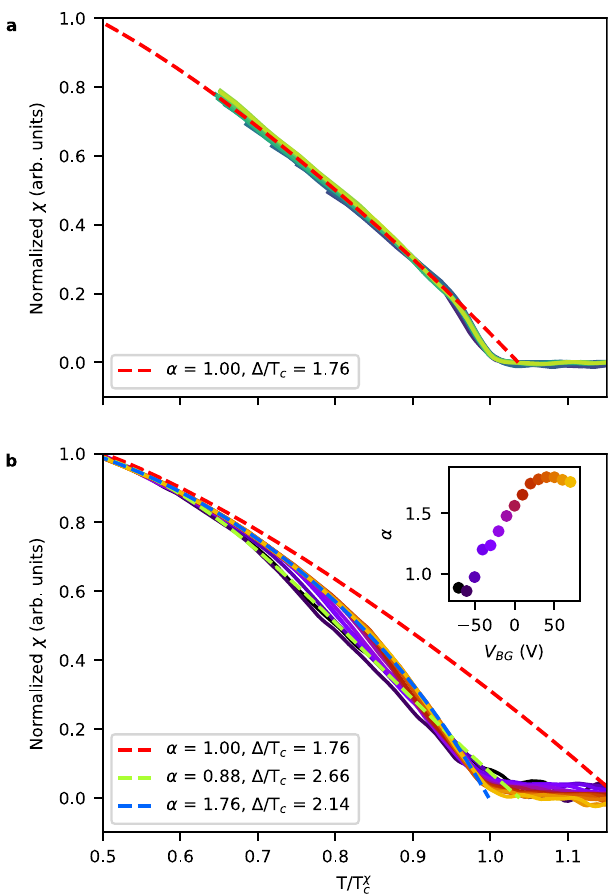
Fig. 4 | Normalized super fl uid response curves. a Gate-tuned super fl uid response χ from deviceAwiththetemperature axisscaledby T χ c andthevertical axis by χ at 0.9 T χ c . Dashed red curve shows a fi t to χ below 0.9 T χ c to the phenomenological model in Eq. (2) assuming a BCS dependence with Δ = T BCS : 76 and a shape parameter α =1. b Gate-tuned super fl uid response of c =1 device B with the axes scaled similarly as in a , but using χ at 0.55 T χ c . Red dashed curve shows same fi t as in a to data below 0.55 T χ c . The green and blue dashed curves show fi ts of Eq. (2) to the full temperature range at V BG = − 70V and V BG =70V, respectively, with no constraints imposed on Δ / T c and α . The inset shows the evolution ofthe shapeparameter, α ,obtainedfrom fi tsatall valuesof V BG . Error bars are smaller than the